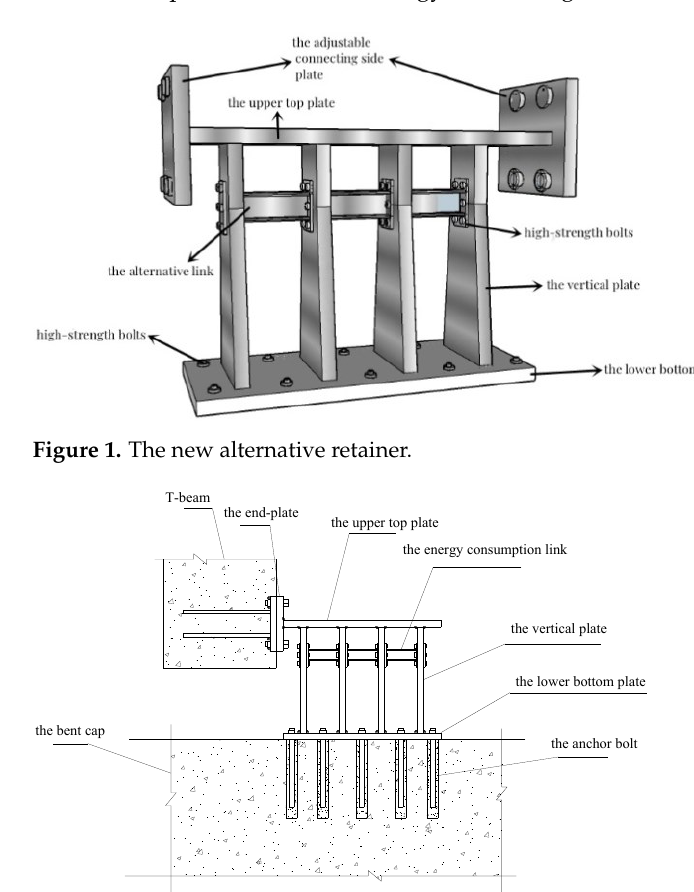
Figure 2. Installation diagram.